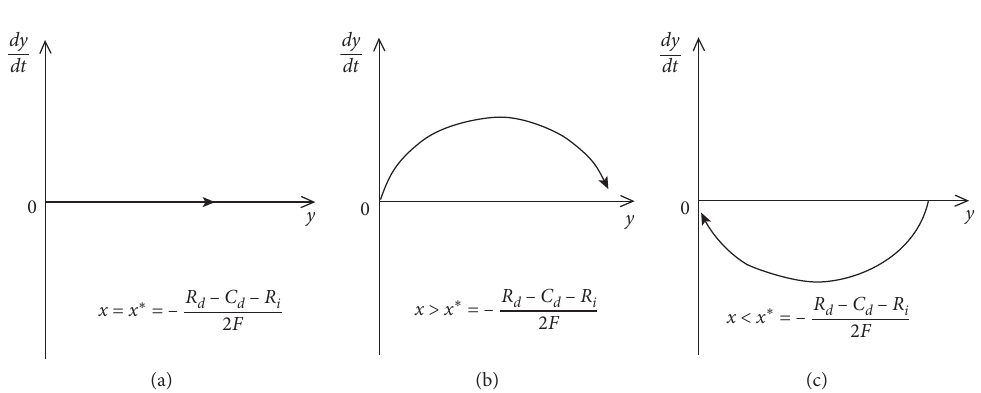
Figure 2: Dynamic evolution path of professional managers.